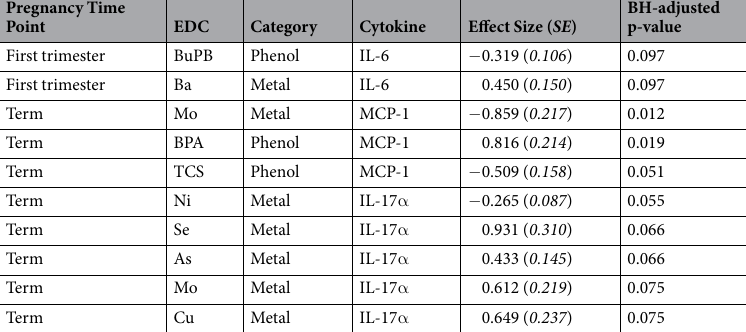
Table 2. EDC associations with maternal cytokine levels in early and late pregnancy. Table 2 displays linear regression results for the association between EDC and maternal cytokine levels, after adjusting for confounding variables including urine dilution, maternal pre-pregnancy BMI, maternal age, history of smoking, mode of delivery, infant sex, and gestational age at delivery. Only statistically significant associations at a Benjamini-Hochberg adjusted p-value < 0.10 are displayed here. No significant associations with cord blood cytokines were observed.